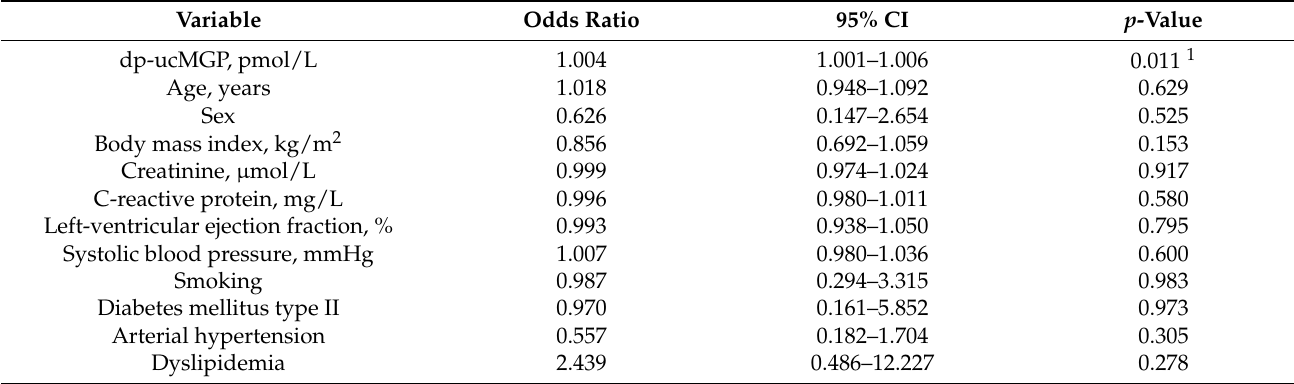
Table 4. Association of dp-ucMGP plasma levels with NSTEMI status adjusted for other confounding variables in the model of stepwise multivariable logistic